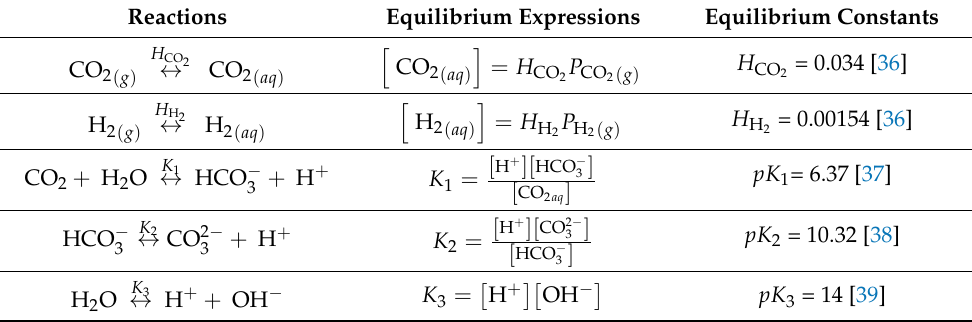
Table 2. Equilibrium reactions considered in the present model for H 2 /CO 2 separation by gas–liquid absorption. Reactions Equilibrium Expressions Equilibrium